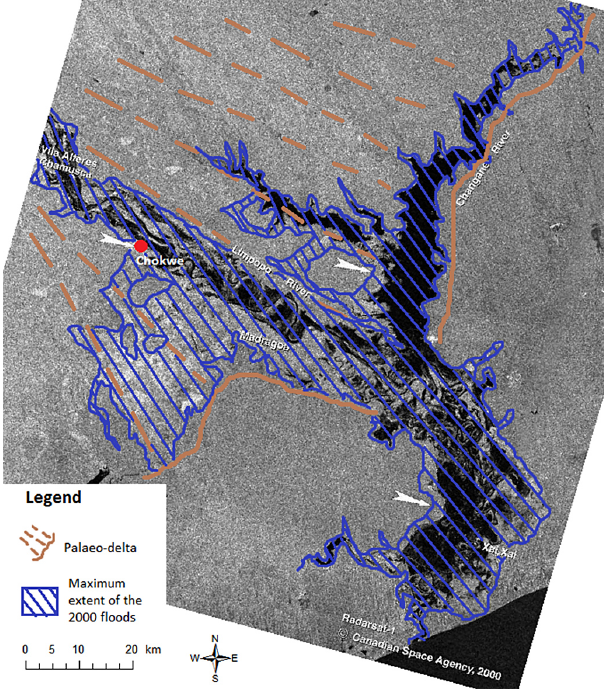
Figure 2. Radarsat-1 image recorded on 28 February 2000 (approx- imately 50m spatial resolution) showing the maximum extent of the 2000 floods affecting the lower